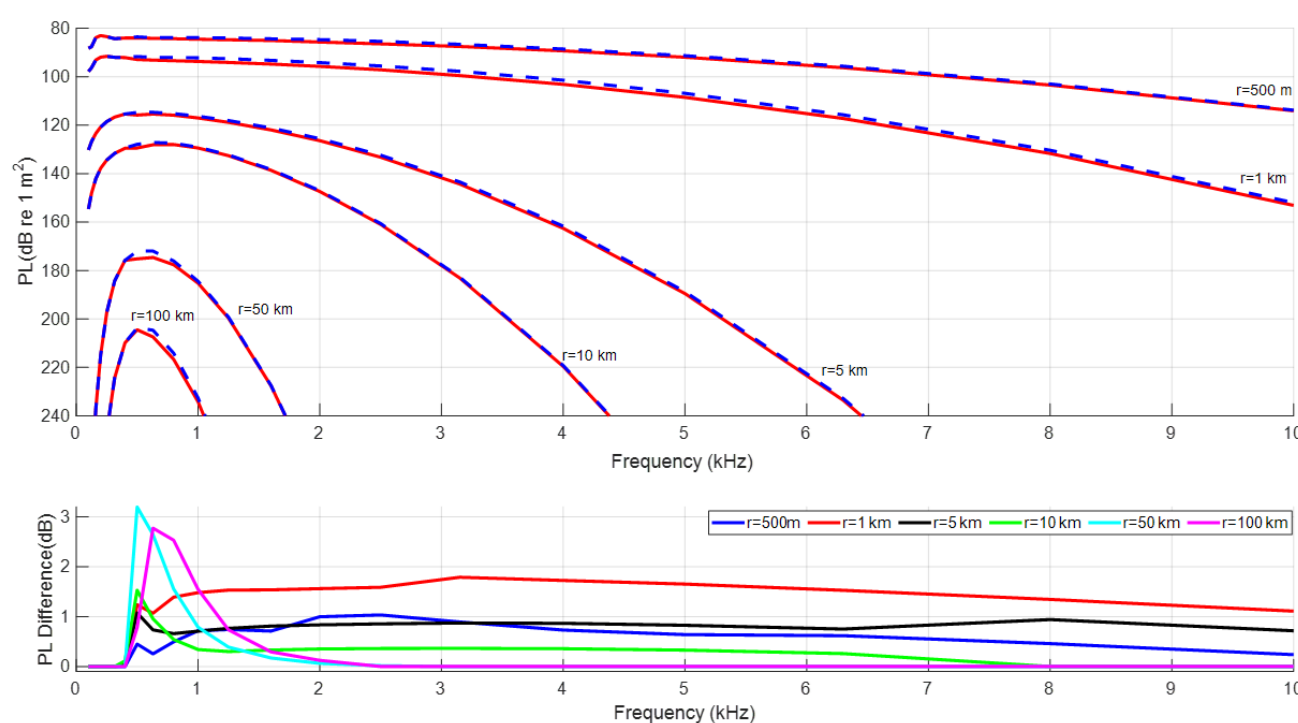
Figure 8. PL vs. frequency comparisons for the different distances over a range-dependent bathymetry. The dashed blue curve is M-Soprano. The red curve is Soprano. The lower figure shows the differences between SOPRANO and M-SOPRANO at different distances, i.e., 500 m, 1 km, 5 km, 10 km, 50 km and 100 km. PL Difference is PL M − SOPRANO − PL SOPRANO . SOPRANO and M-SOPRANO both use the same mode sum up to 400 Hz, which